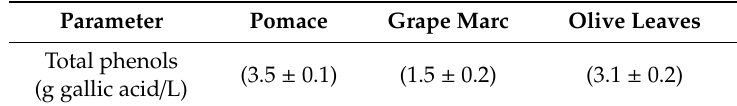
Table 1. Total phenols of pomace, grape marc, and olive leaves. Data are expressed as mean ± confidence interval ( n = 3) at p ≤ 0.05.